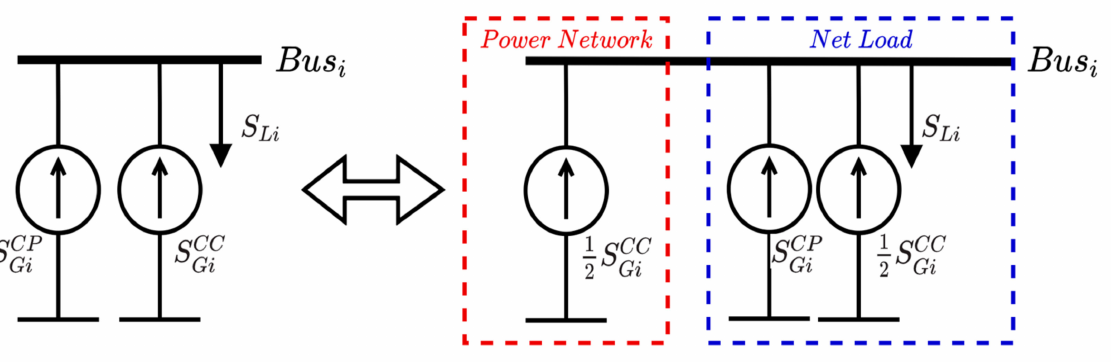
Figure 5. Illustration of CP-DGS and CC-DGS